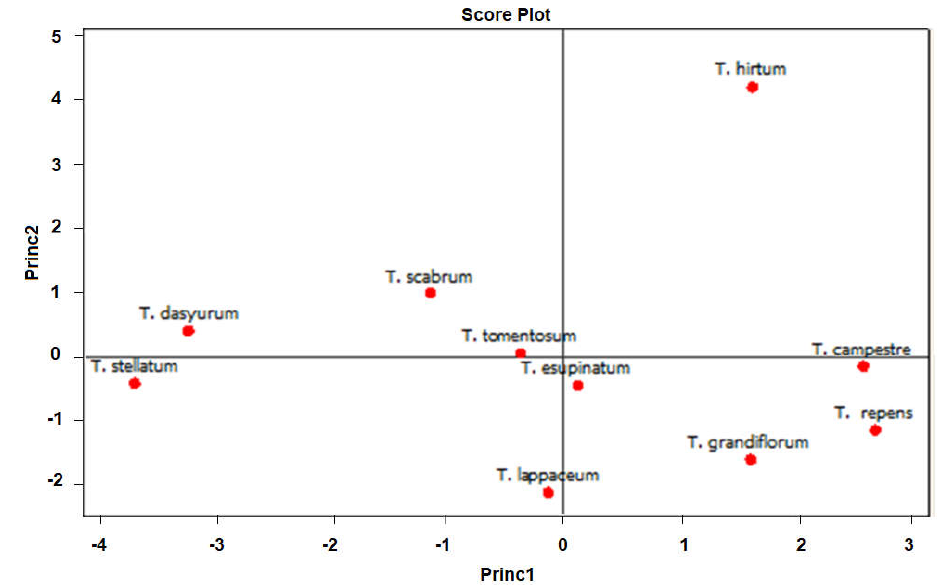
Fig. 2. Scatter plot of 10